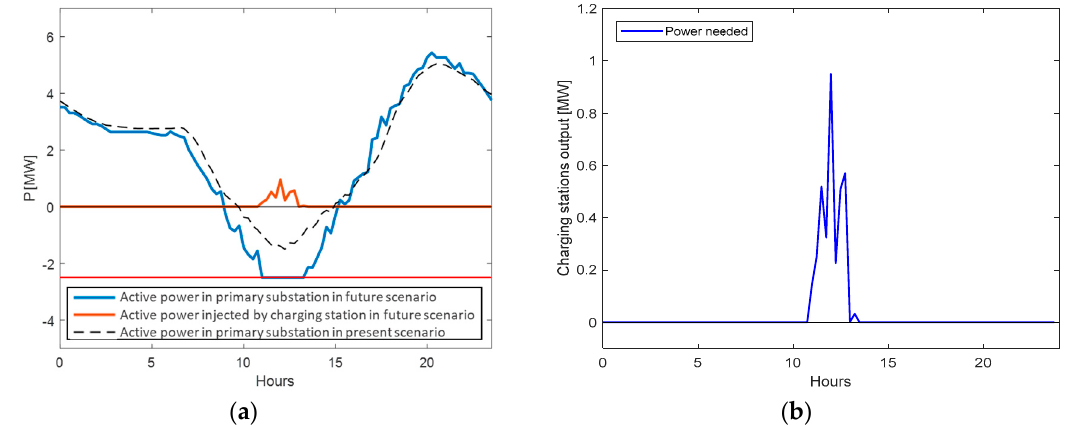
Figure 6. Active power at MV side of the primary ESS and power injected by the EV pole station for the reverse power flow shaving ( a ); power withdrawn by the EV pole stations ( b ).